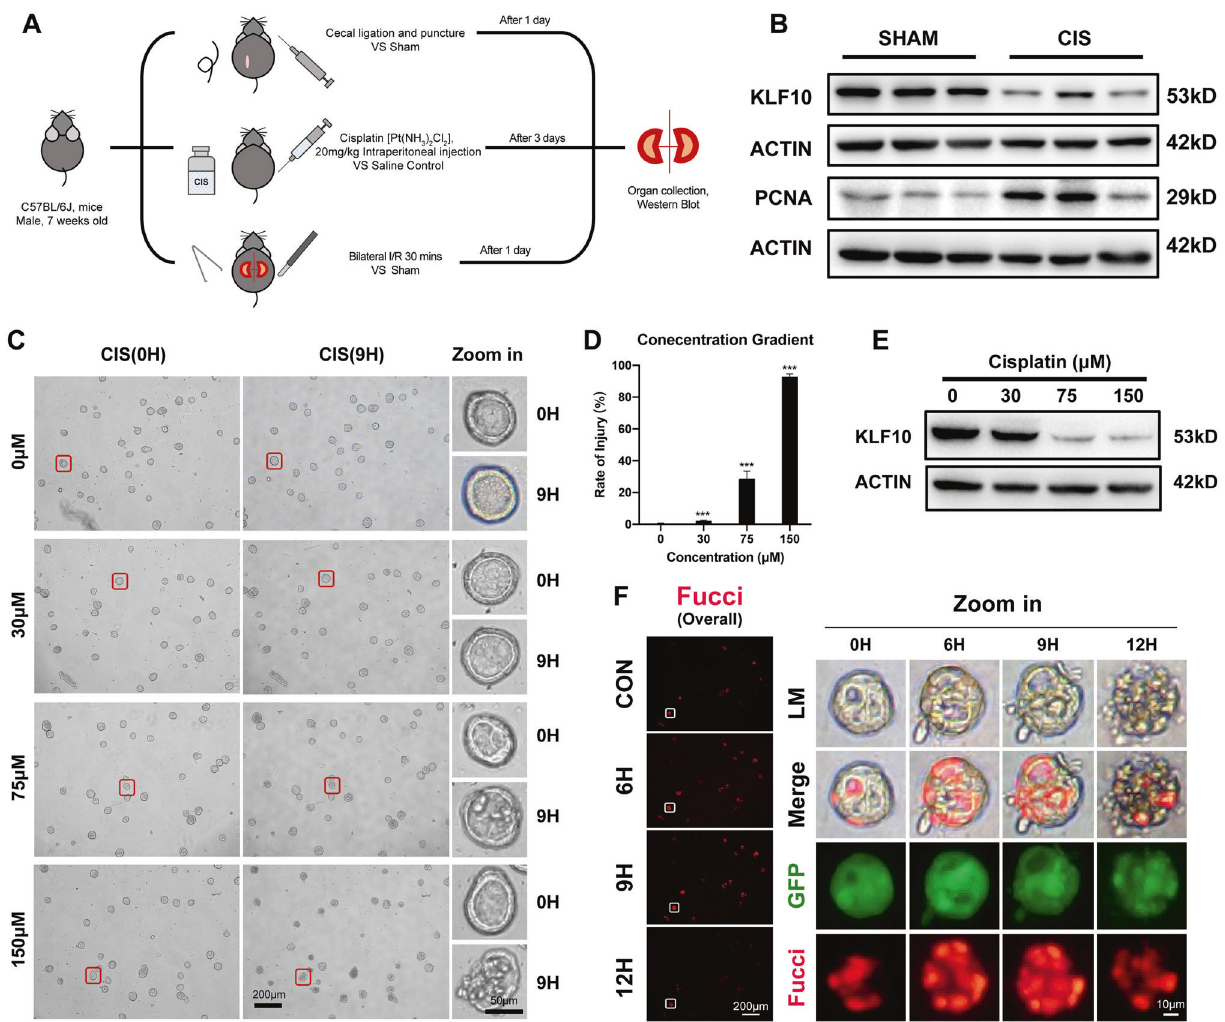
Fig. 2 KLF10 was down-regulated in multiple AKI mouse models and 3D renal tubule injury models. A Flowchart detailing bilateral IR or CLP surgery and cisplatin treatment regime in C57BL/6 J mice. B Representative immunoblot analysis of KLF10 and PCNA in kidney tissues from cisplatin-induced AKI mouse model. ACTIN served as the standard. n = 6 per group. C , D The morphology and injury rate of 3D renal tubular model treated with cisplatin of different concentration. E Representative immunoblot analysis of KLF10 in cisplatin treated 3D renal tubular model. ACTIN served as the standard. F Fluorescence images of 3D tubular cisplatin-induced AKI model (75 μ M) at different time points re fl ecting the injury degree (LM - light microscope and GFP) and proliferative activity (Fucci-overall, Merge and Fucci). *** p < 0.001 vs control group at the same experimental